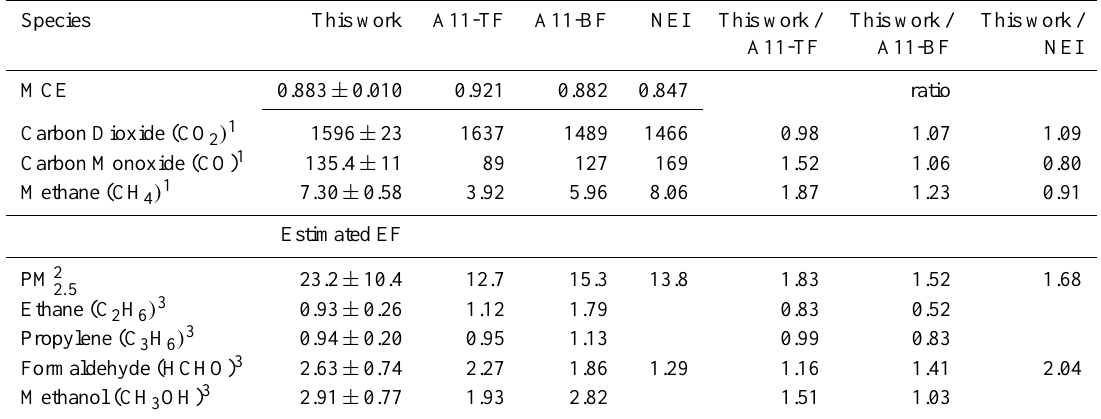
A11-TF A11-BF NEI